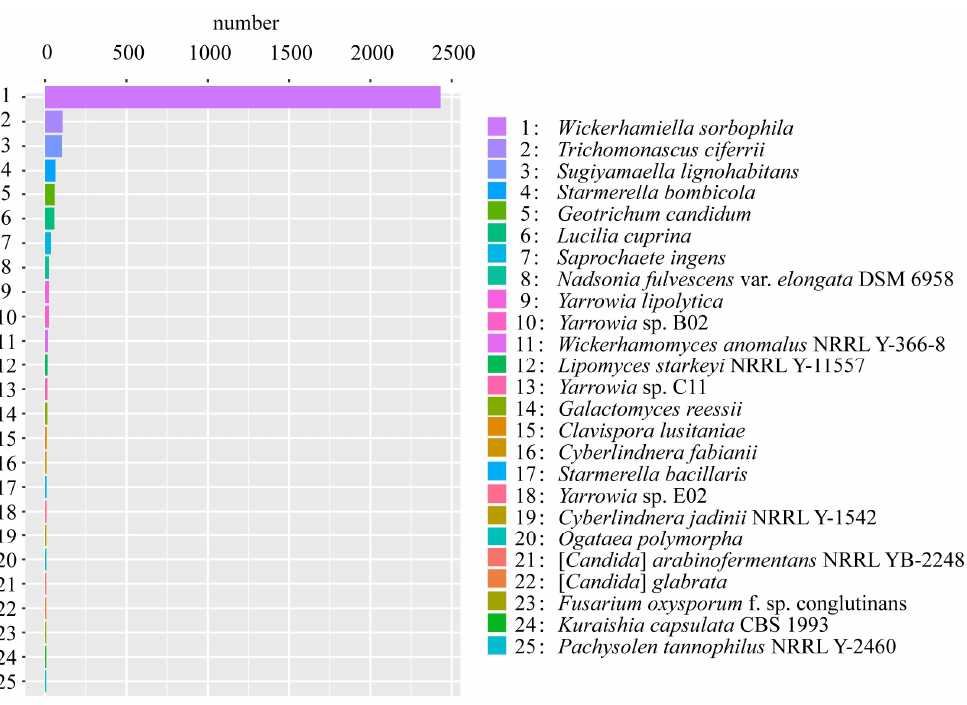
Figure 2. Species information statistics of S.bacillaris CC-PT4 genome annotated in NCBI nr (top 25 species). Table 1. Sequence identity statistics of the S. bacillaris CC-PT4 genome annotated in NCBI nr (top 10).